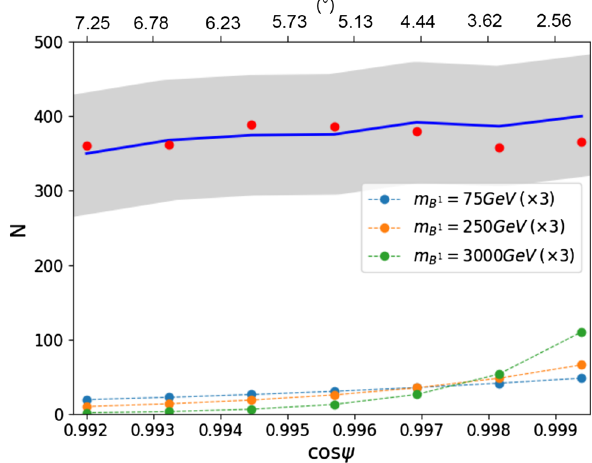
Fig. 5 Expected background (dark blue line) within the range of max- imum systematic uncertainties (shaded area), the actual number of detected events at every angular bin (red dots) and the expected sig- nal (multiplied by three for visualization) for some values of m B 1 (light blue,orangeandgreen),asafunctionofanglewithrespecttotheSun(in cosine in the lower axis and degrees in the upper). Data from Ref.